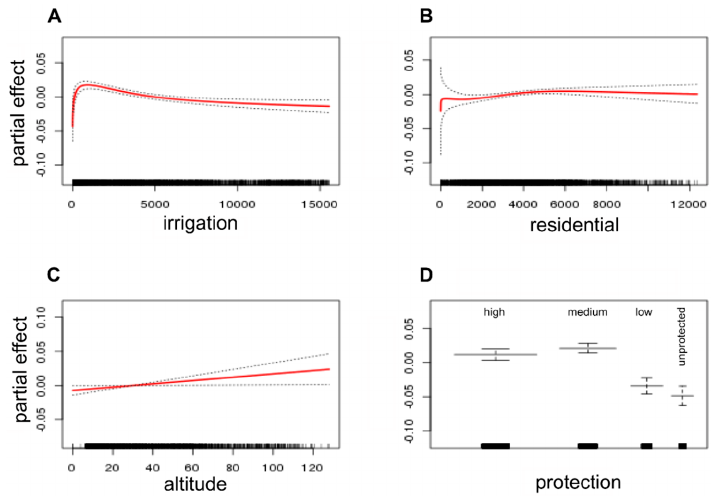
Figure 8. Partial effects of predictors in the best gam model for the correlation between annual hydroperiod and precipitation (R-squared) for all water bodies. ( A ) Irrigation = smoothing spline of log distance to irrigated cultures; ( B ) residential = smoothing spline of log distance to residential areas, ( C ) altitude = altitude above sea level; ( D ) protection = protection level (factor, four levels).